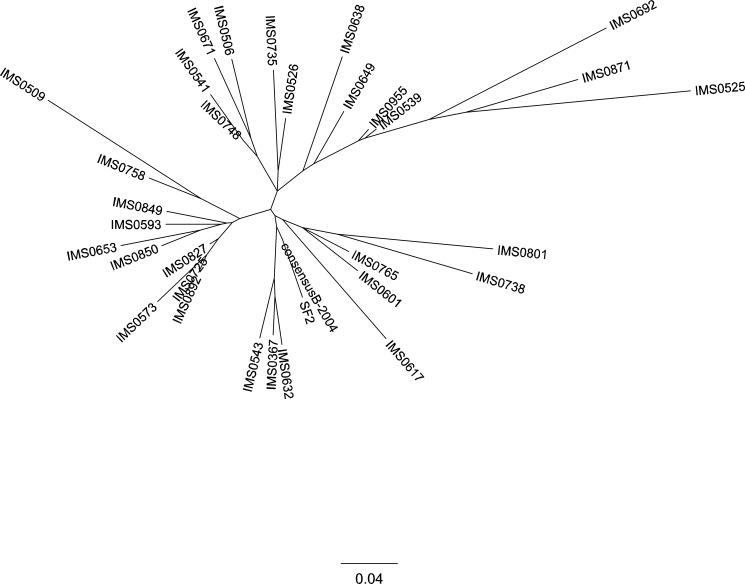
Phylogenetic tree of the nef gene nucleotide sequences of HIV-1 in the plasma.HIV-1 nef gene in the plasma from the 31 patients in the study was amplified by the RT-PCR and directly sequenced. Published nef sequences from SF2 strain (GenBank accession number: K02007) and global subtype B consensus in 2004 (provided at HIV database; http://www.hiv.lanl.gov/content/sequence/NEWALIGN/align.html) were included as controls.